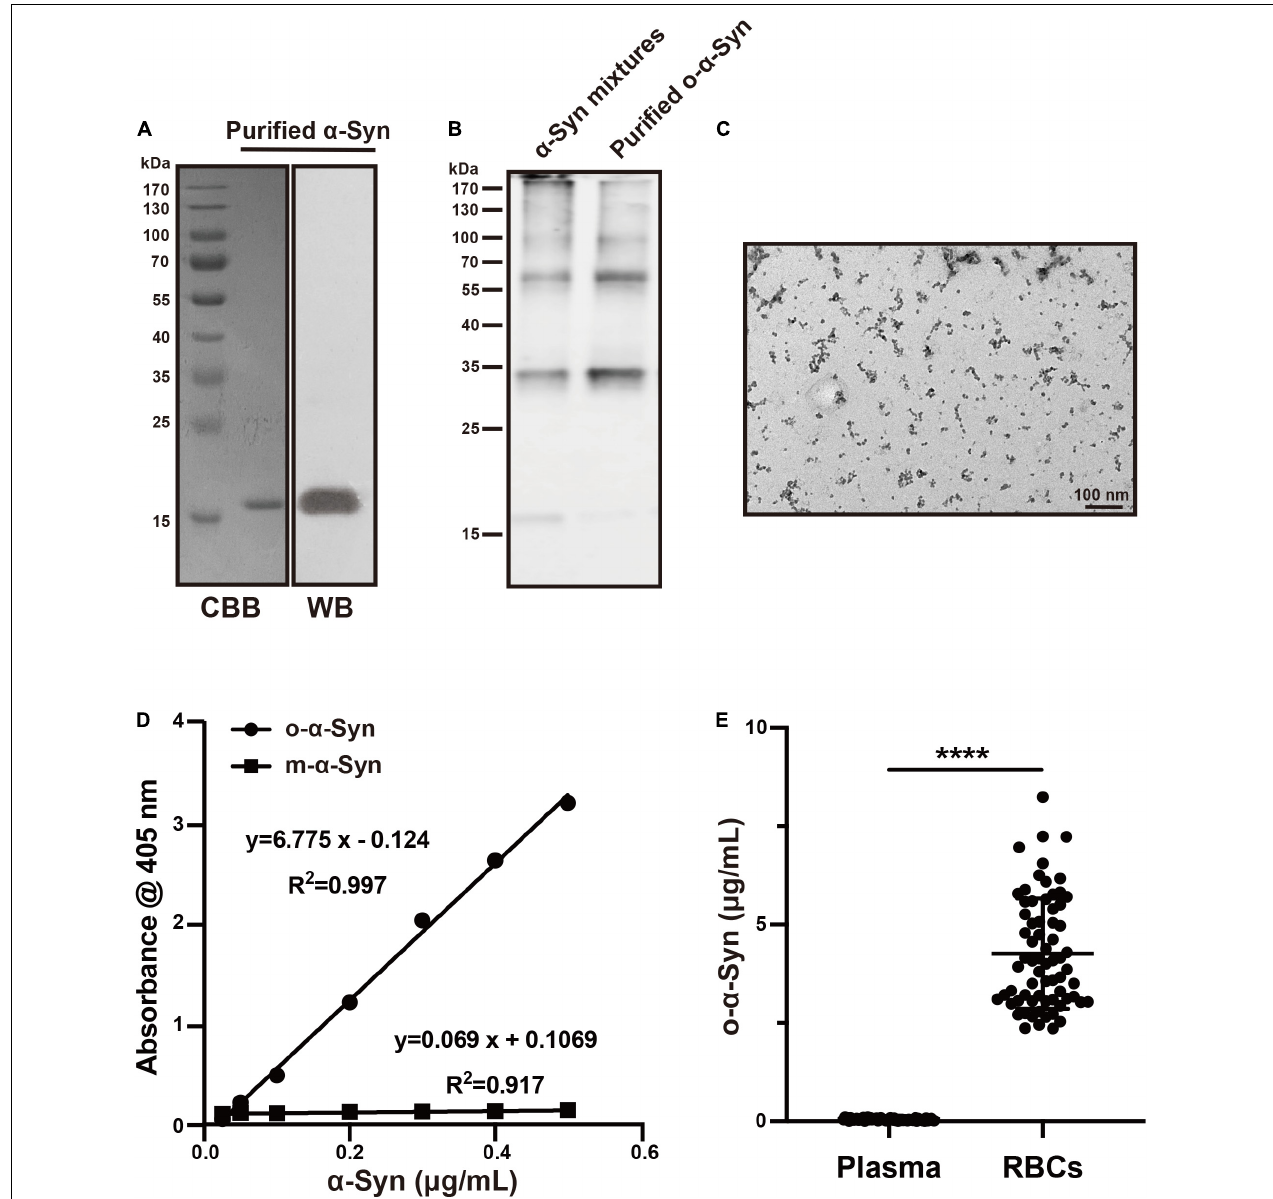
FIGURE 1 | O- α -Syn characterization and its concentrations in plasma and Red Blood Cells (RBCs). (A) Recombinant m- α -Syn showed a single band at 17 kDa in CBB staining and Western blot analysis. (B) Monomers (17 kDa) and oligomers (34–170 kDa) was in non-purified samples; oligomers (34–170 kDa) was in purified samples. (C) Transmission electron microscopic analysis of the purified o- α -Syn, which presented spherical particles. (D) M- α -Syn and o- α -Syn were detected using o- α -Syn-specific ELISA. A linear correlation between absorbance at 405 nm and α -Syn concentration was observed for o- α -Syn ( R 2 = 0.997) but not for m- α